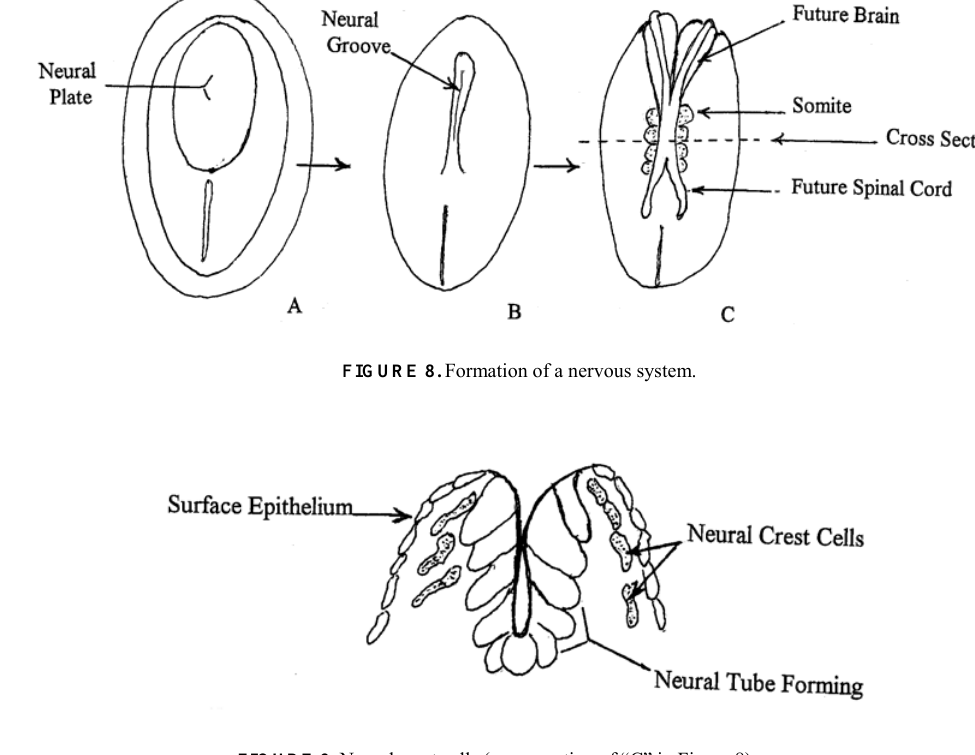
FIGURE 9 . Neural crest cells (cross-section of “C” in Figure